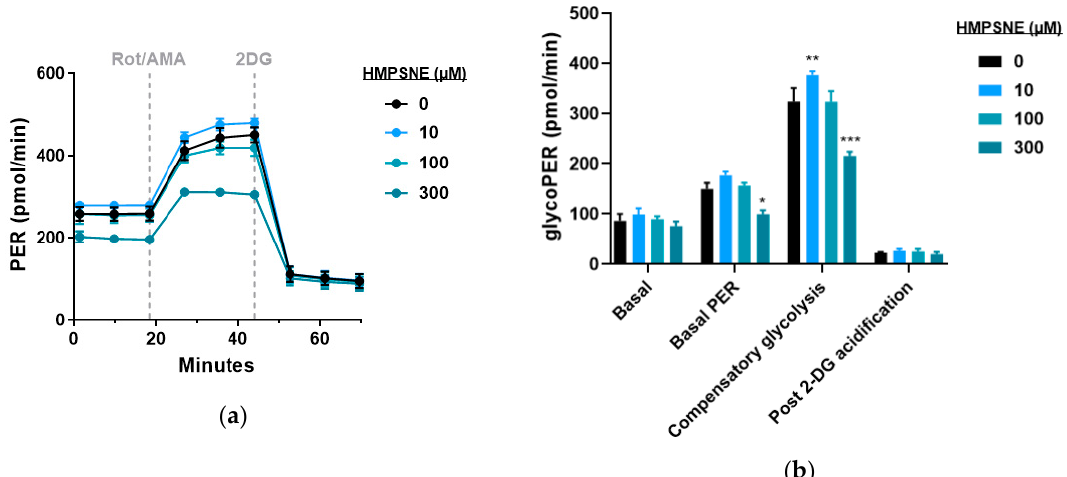
Figure 10. Effect of HMPSNE on glycolytic parameters in CT26 cells: ( a ) Proton efflux rate (PER) profiles in control and HMPSNE treated cells. Dashed lines indicate the addition of specific mitochondria and glycolysis stressors into the media. Results are indicated as mean ± SEM of three replicates per condition; ( b ) analysis of glycolysis-related bioenergetics parameters. Results are indicated as mean ± SEM of three independent replicates per condition, and Dunnett’s multiple comparisons tests are shown vs. 0 µM of each parameter respectively (* p < 0.05, ** p < 0.01, *** p < 0.001).